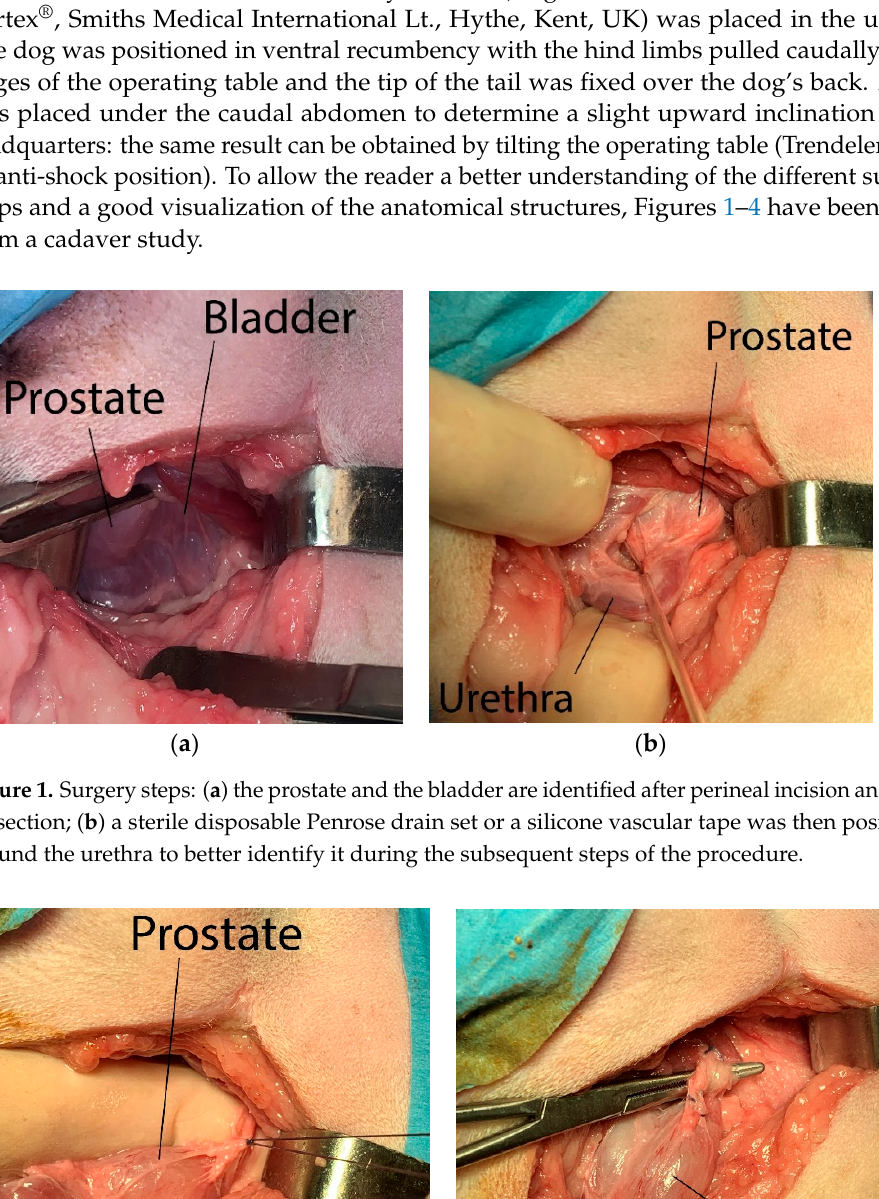
( b ) Figure 3. Surgery steps: ( a ) the prostate was tractioned caudally; ( b ) stay suture placement in the neck of the bladder.